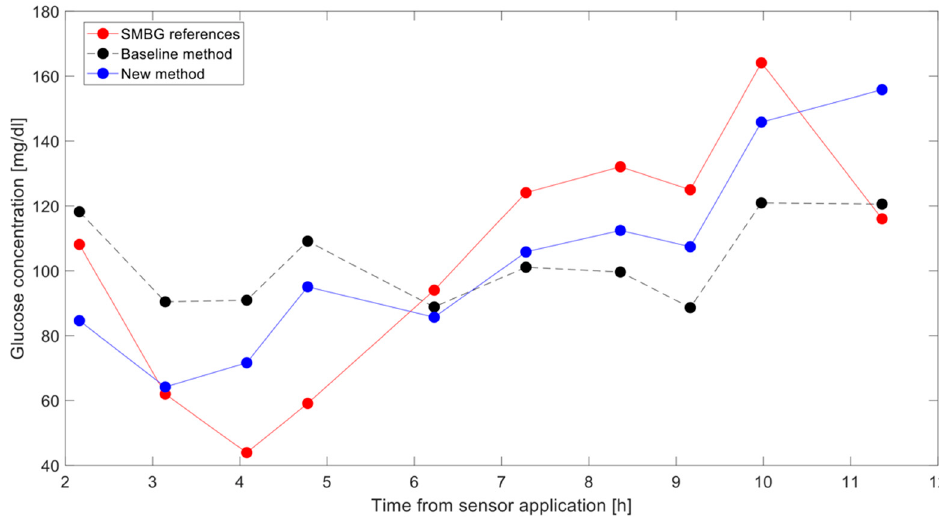
Figure 5. Reconstructed BG time-series with the baseline method (dashed black line) and with the new method (continuous blue line) versus self-monitoring BG (SMBG) references (red line) in a representative run and subject.